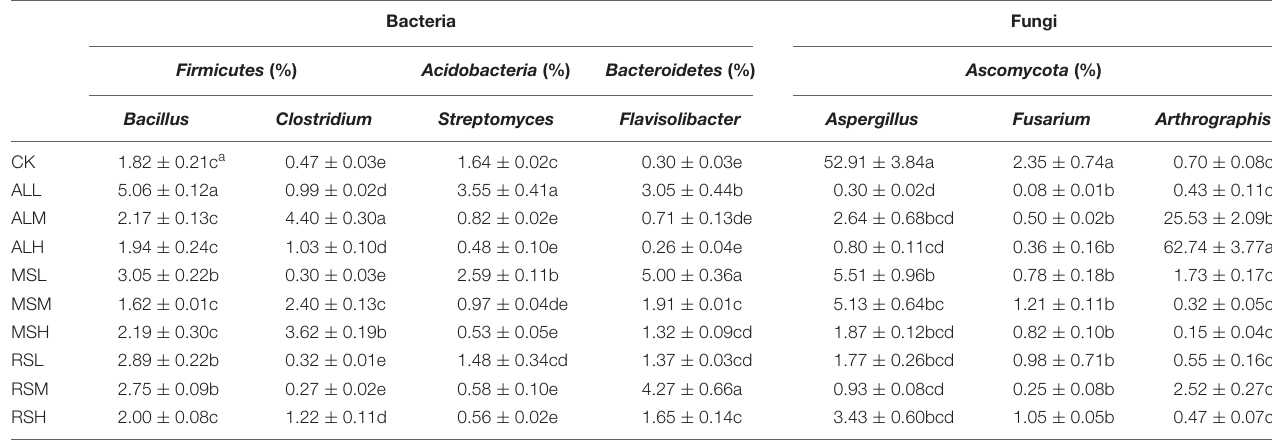
TABLE 3 | Relative abundances of dominant functional genera and pathogenic genera of bacteria and fungi in tomato rhizosphere soils.